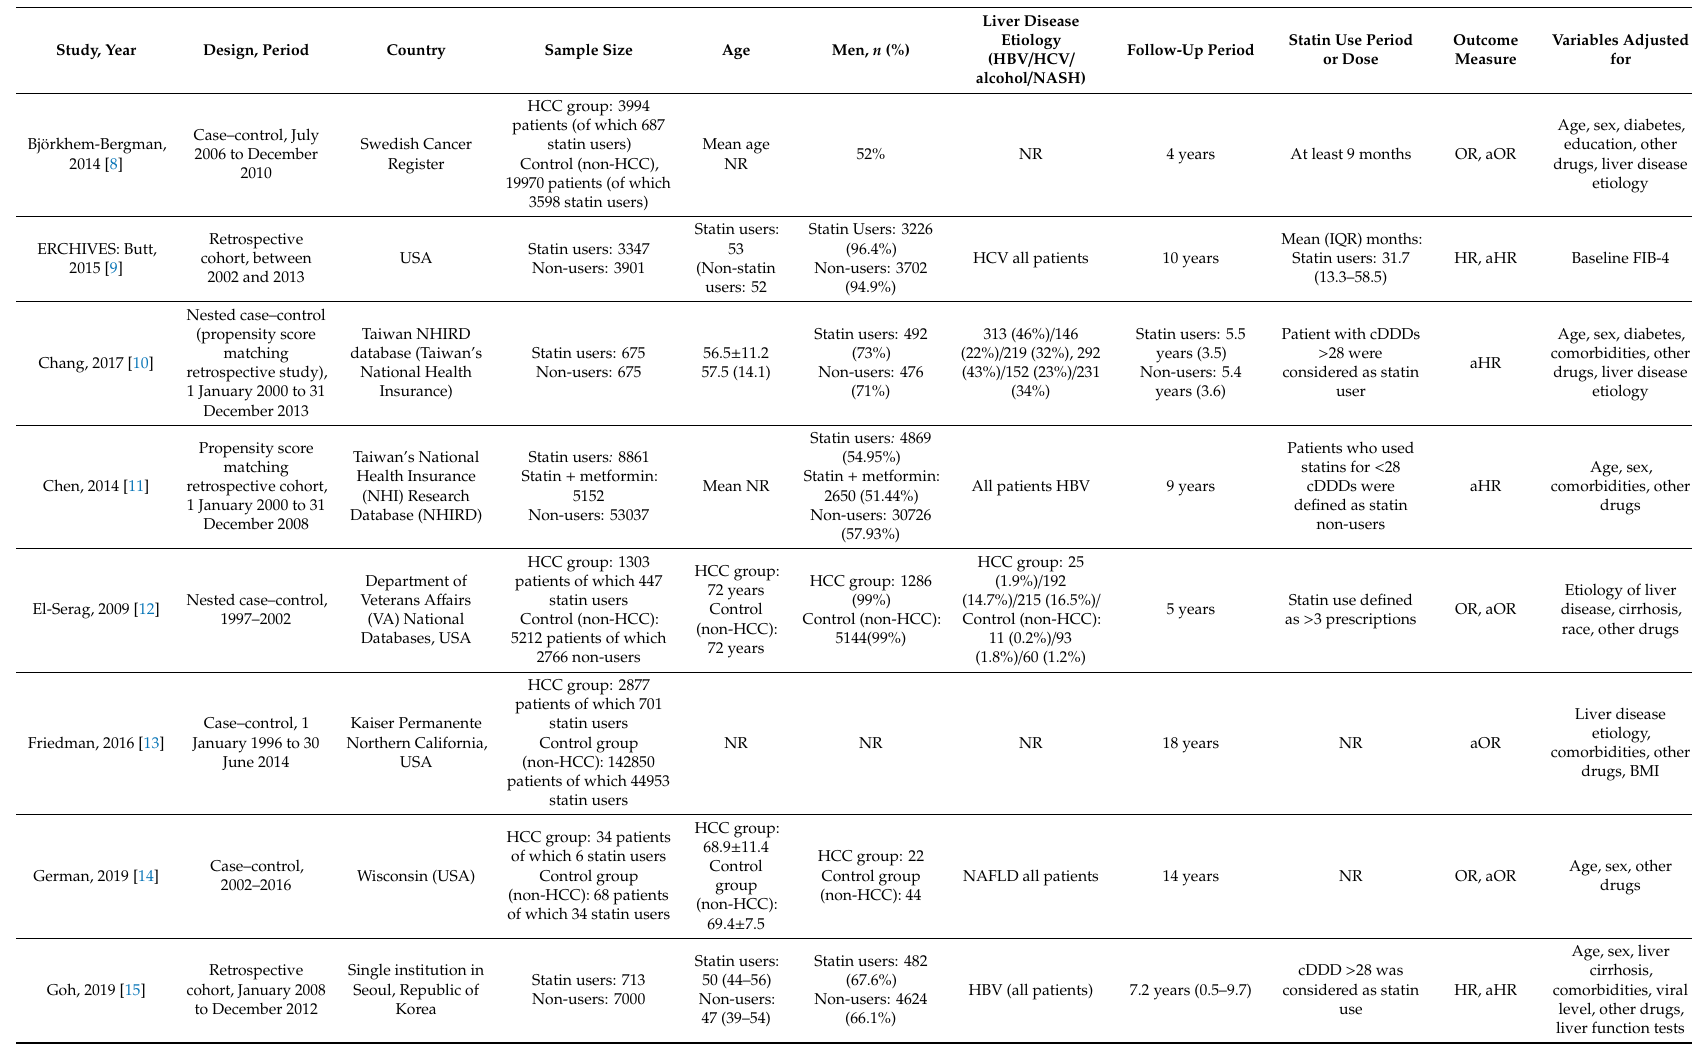
Table 1. Characteristics of included